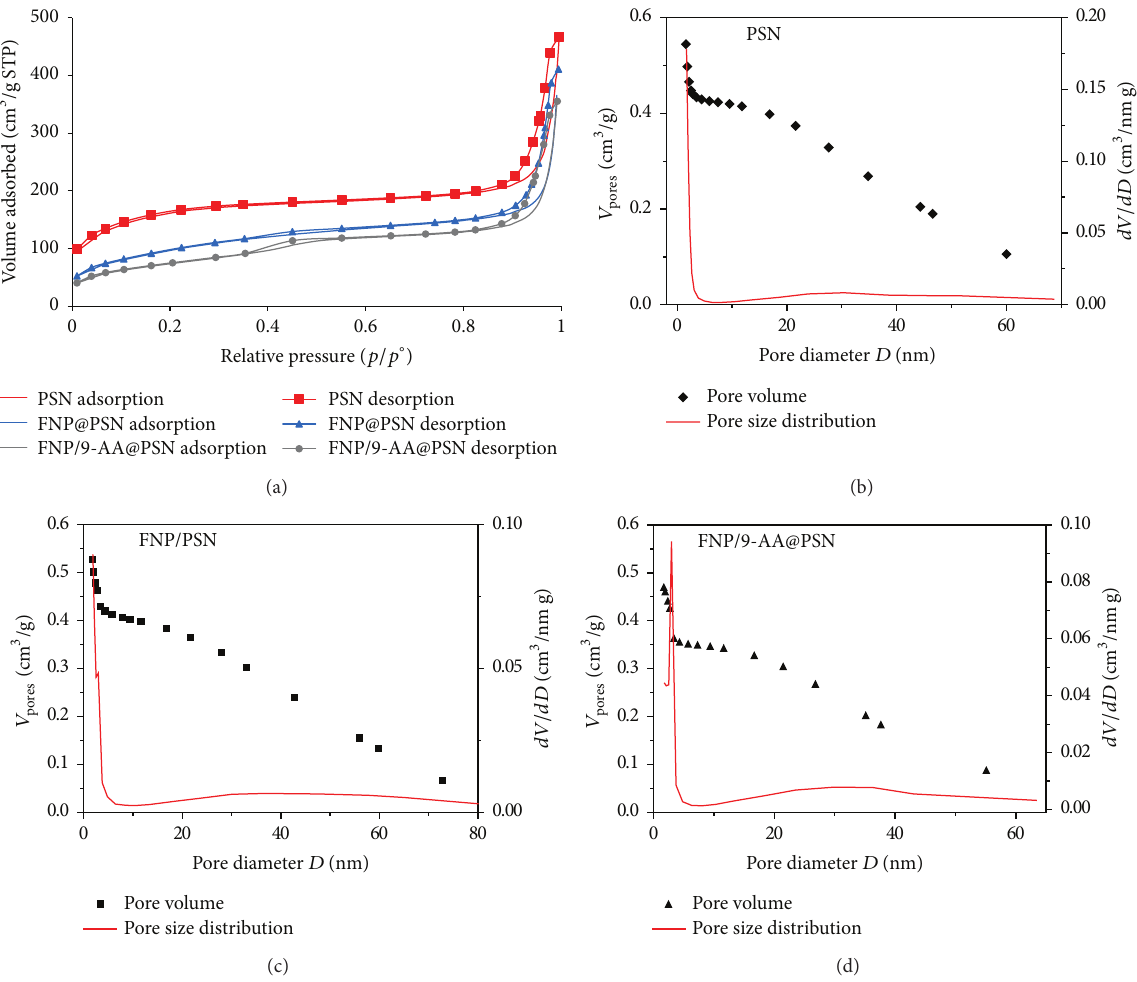
Figure 2: (a) Nitrogen adsorption/desorption isotherms and (b)–(d) BJH pore size volume and size distributions for PSN, FNP@PSN, and FNP/9-AA@PSN.